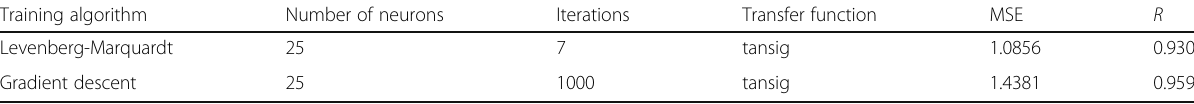
Table 2 Network training configuration and results Training algorithm Number of neurons